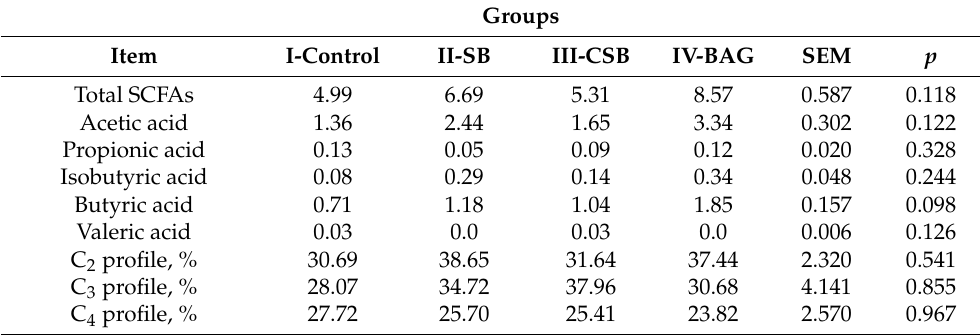
Table 7. Concentrations of short-chain fatty acids ( µ mol/g *) in the cecal digesta of 15-week-old turkeys. Item